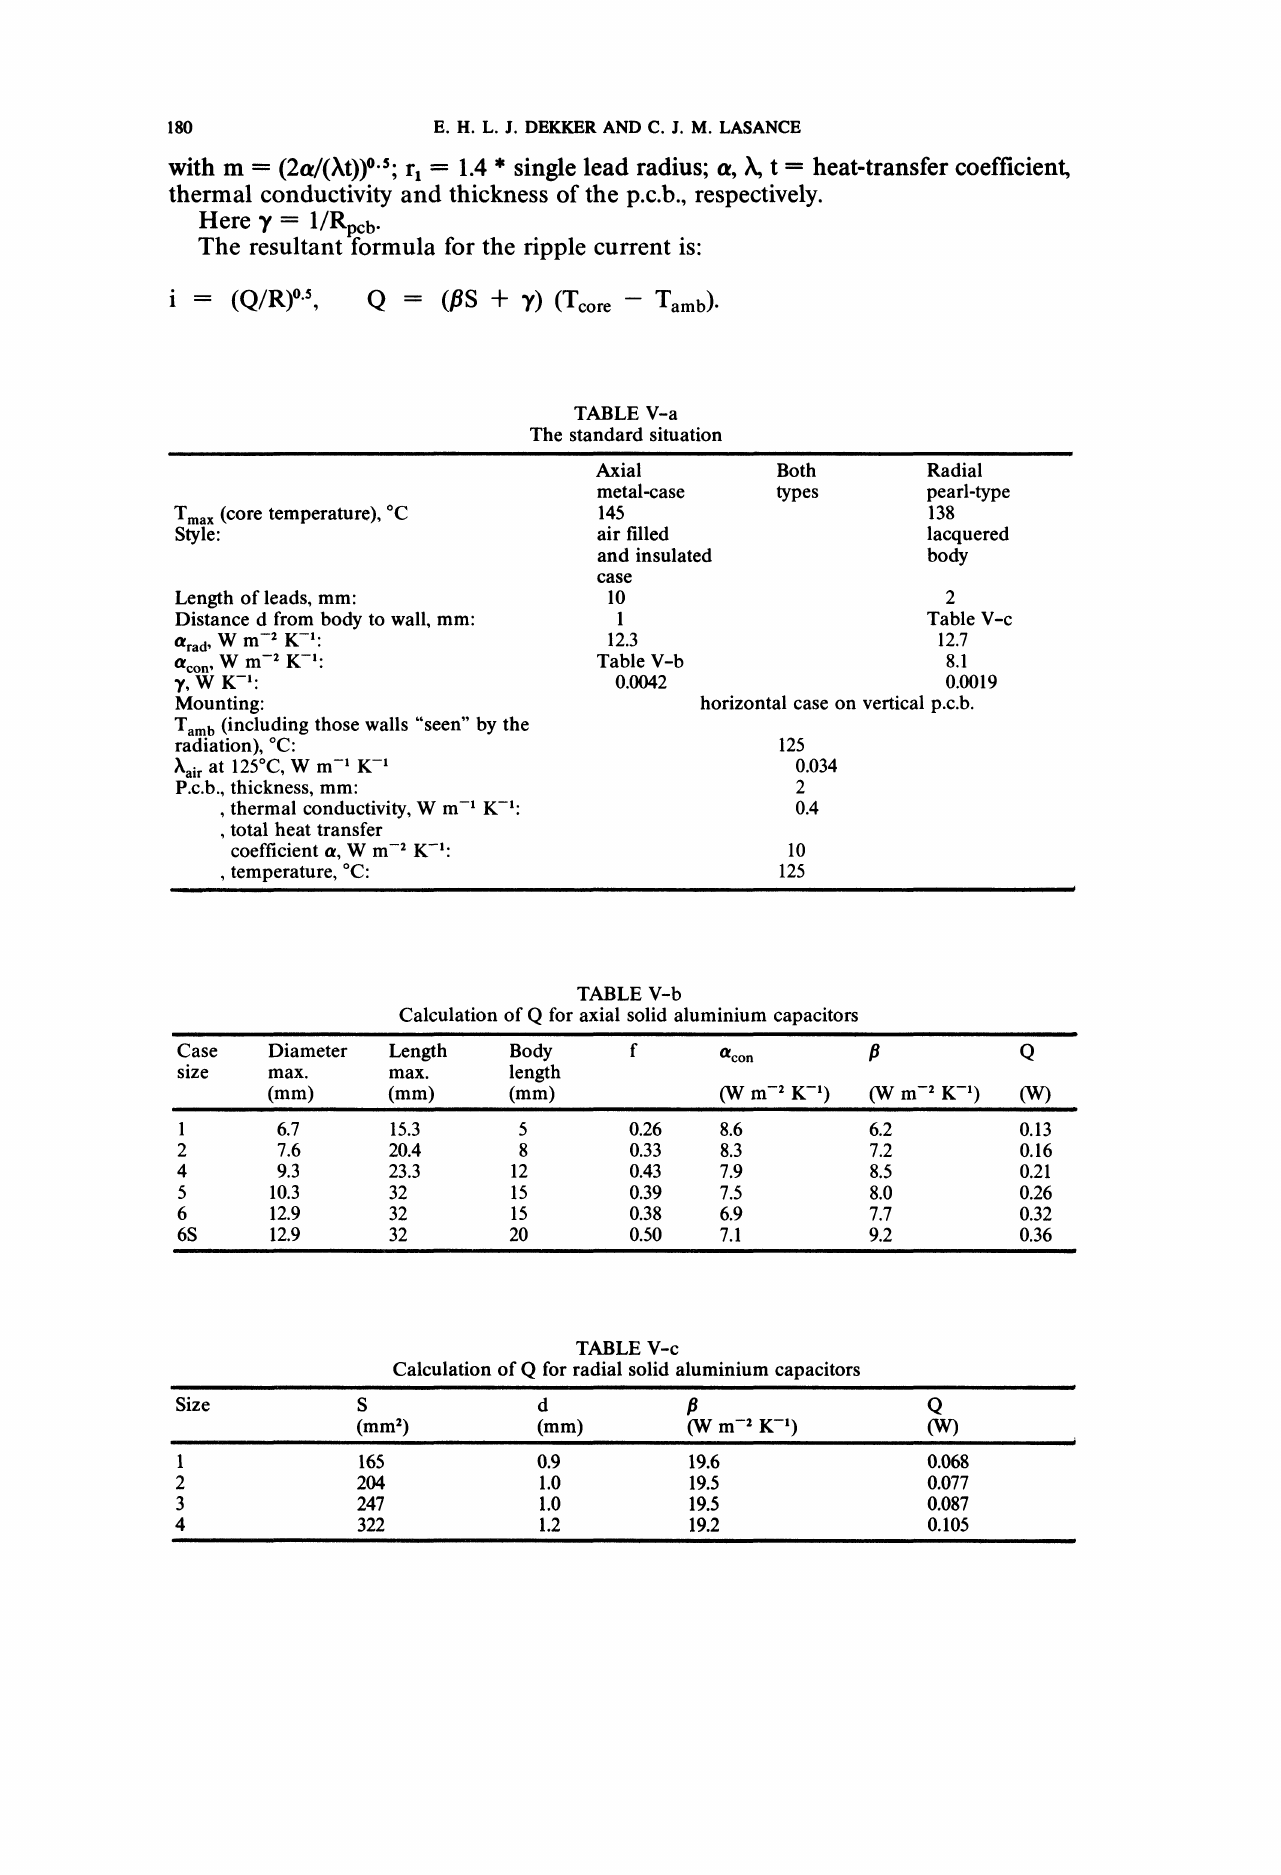
TABLE V-a The standard situation